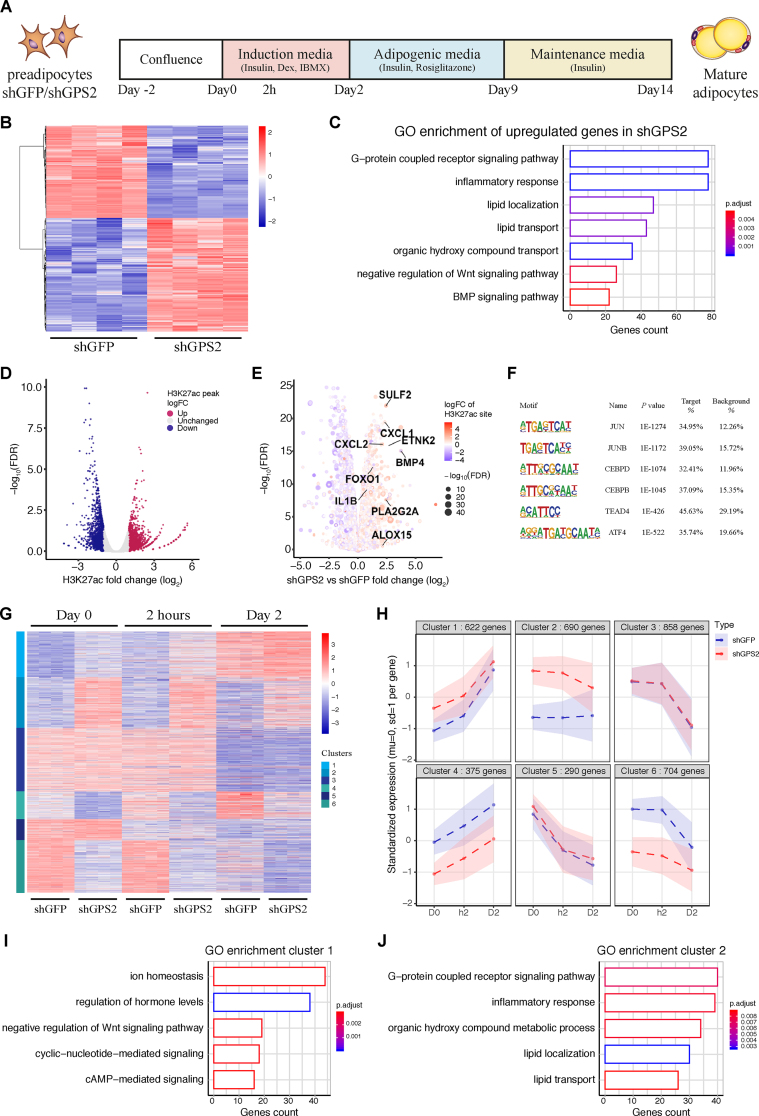
GPS2 depletion in preadipocytes increases transcription of genes involved in adipocyte commitment. (A) Schematic representation of the experimental design. hMADS shGFP/shGPS2 preadipocytes were 2 days at confluence before the induction of differentiation with a standard cocktail containing IBMX, dexamethasone, and insulin for 2 days. The cells were then maintained in adipogenic medium containing rosiglitazone until day 9, followed by a maintenance medium containing only insulin until day 14. (B) Heatmap of significant (adj. p-value < 0.05 and LogFC > 0.5 or LogFC < −0.5) gene expression changes in shGFP vs shGPS2 preadipocytes at day 0 (n = 4). (C) Gene ontology enrichment of significantly upregulated genes in shGPS2 preadipocytes. (D) Volcano plot showing the average logFC of H3K27ac peaks in shGPS2 vs shGFP preadipocytes (n = 2). (E) Volcano plot representing global mRNA expression along with logFC of H3K27ac (color from blue to red) and -log (FDR) (dot size) in shGPS2 vs shGFP preadipocytes. (F) Transcription factor motif analysis of GPS2-occupied regions in human preadipocytes. (G) Heatmap of significantly (adj. p-value < 0.05 and LogFC > 0.5 or LogFC < −0.5) changed gene expression in shGFP vs shGPS2 hMADS cells at day 0, 2 h, and day 2 (n = 4). (H) Cluster analysis of gene expression profiles during the early stage of adipocyte differentiation (days 0–2) in shGFP and shGPS2 cells (n = 4). (I and J) Gene ontology enrichment of clusters 1 and 2.